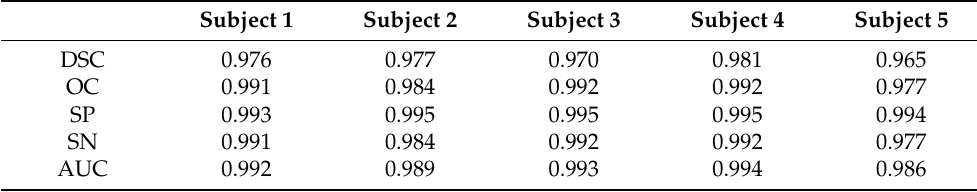
Table 4. Evaluation results for cerebellar tissue with fissures (model M2) in our